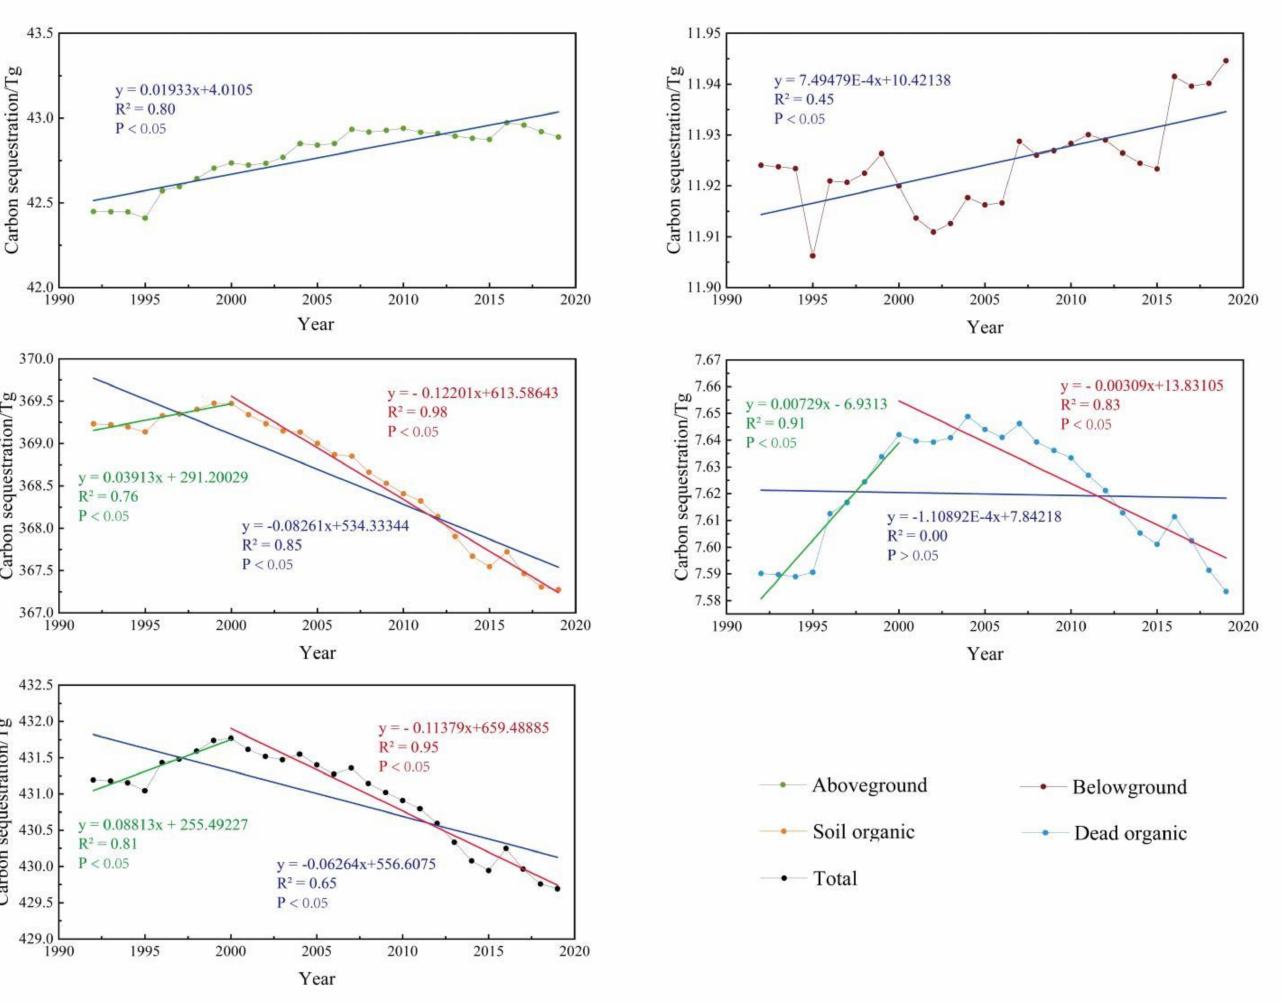
Figure 6. Carbon storage dynamics of Hainan Island from 1992 to